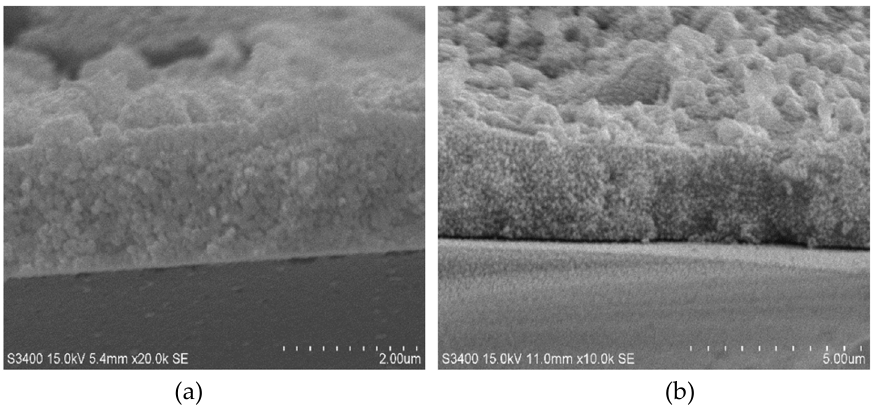
Figure 6. SEM morphology of the CH 3 NH 3 PbI 3 /TiO 2 composite thin film ( a ) prepared by the proposed method; ( b ) by the traditional two-step spin-coating method.